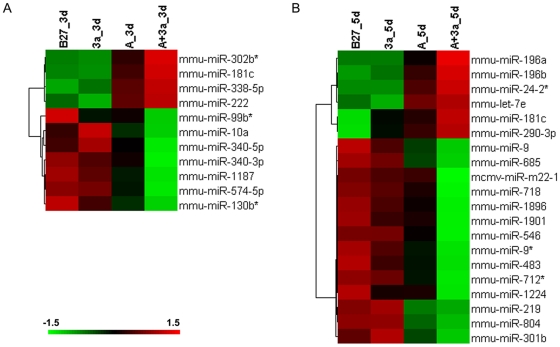
Synergistically regulated miRNAs by Wnt3a and Activin A during mouse DE formation.Synergistically regulated miRNAs were identified using the criteria stated in the results section. The synergistically expressed miRNAs identified at day 3 (A) and day 5 (B) was presented using the heatmap visualization. No miRNA was found to be synergistically regulated at day 1 samples under current cutoffs. A: Activin A; 3a:Wnt3a.